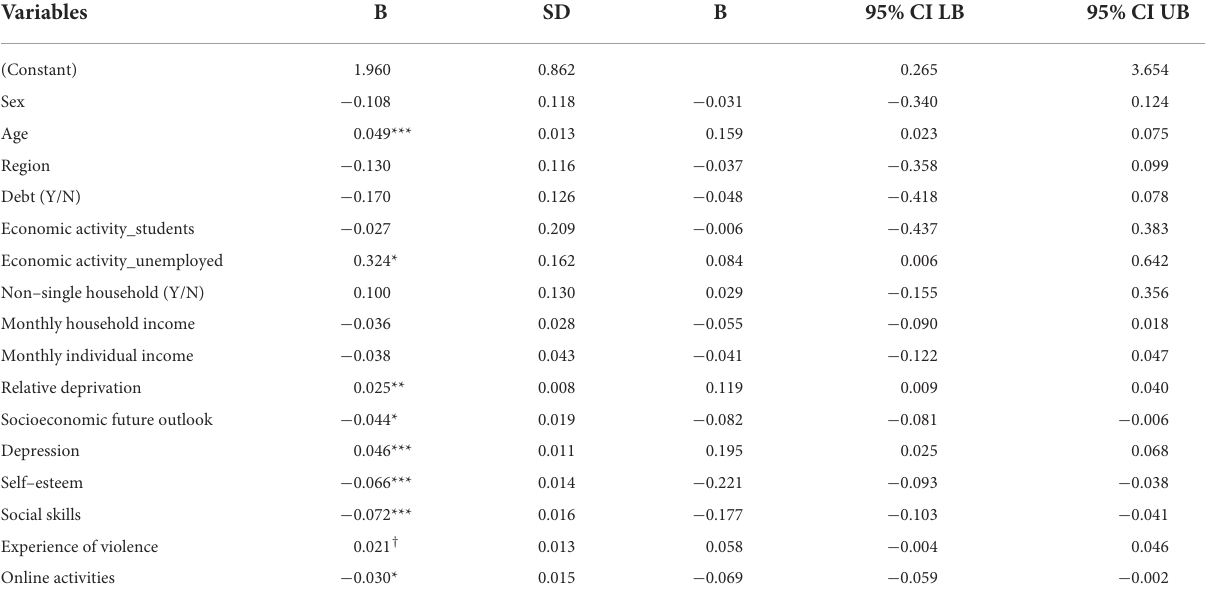
TABLE 3 Results of regression